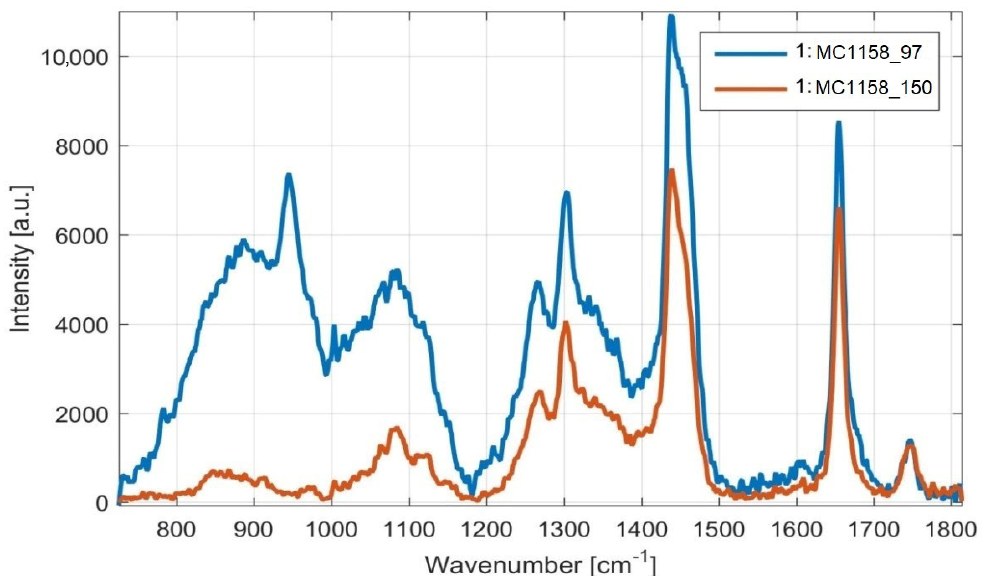
Figure 11. Raman scattering spectrum of intracellular lipids of the yeast M. chrysoperlae MC 1158 on two different media. Legend: Metschnikowia chrysoperlae 1158 cultivated on medium with C/N ratio 97 (MC1158_97, blue trace) and on medium with C/N ratio 150 (MC1158_150, red trace).